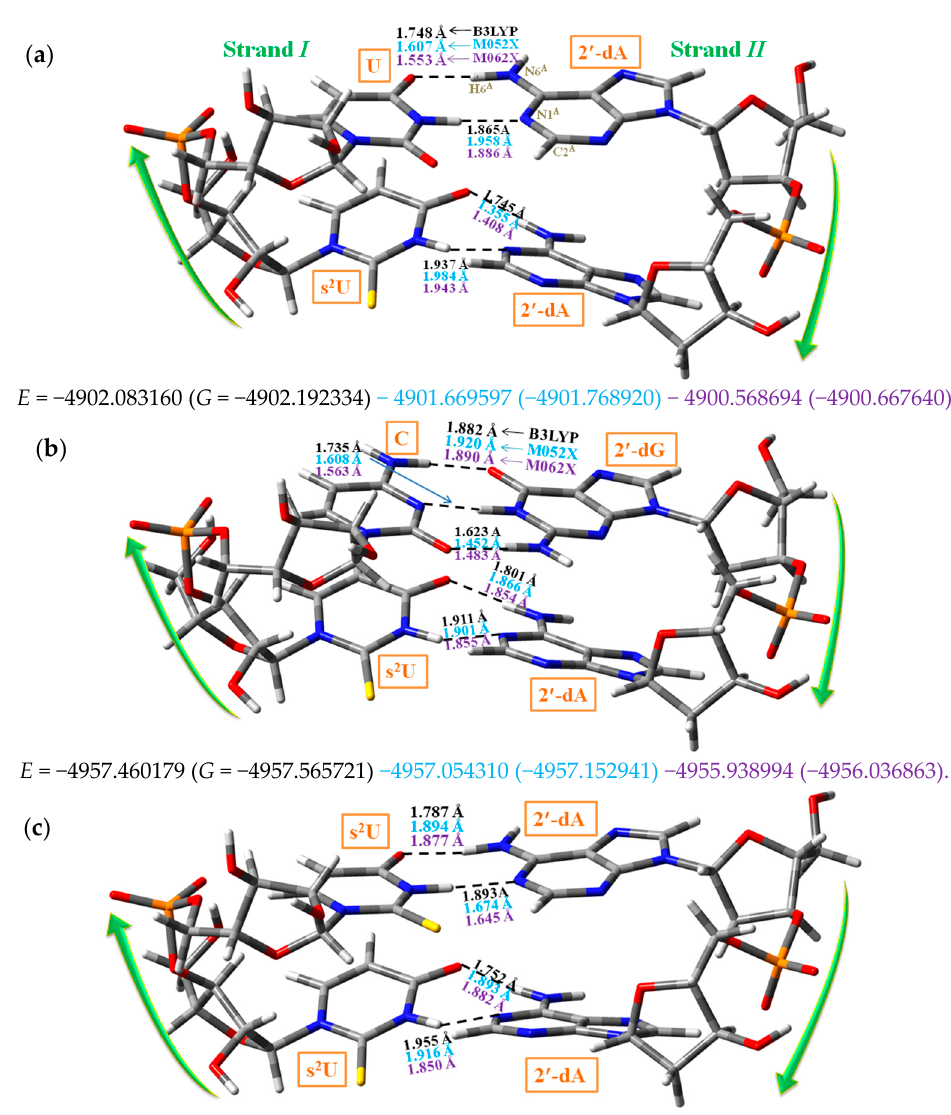
Figure 8. Comparison of the intermolecular H-bonds values optimized by the B3LYP (in black color), M052X (in blue color) and M062X (in violet color) DFT methods, in the microhelixes with two nucleotide pairs and in strand I with: ( a ) Uridine and 2-thiouridine; ( b ) cytidine and 2-thiouridine and ( c ) 2-thiouridine and 2-thiouridine. The total electronic energy ( E ) and Gibbs energy ( G ) in AU determined by each DFT method is listed at the end of each plot.